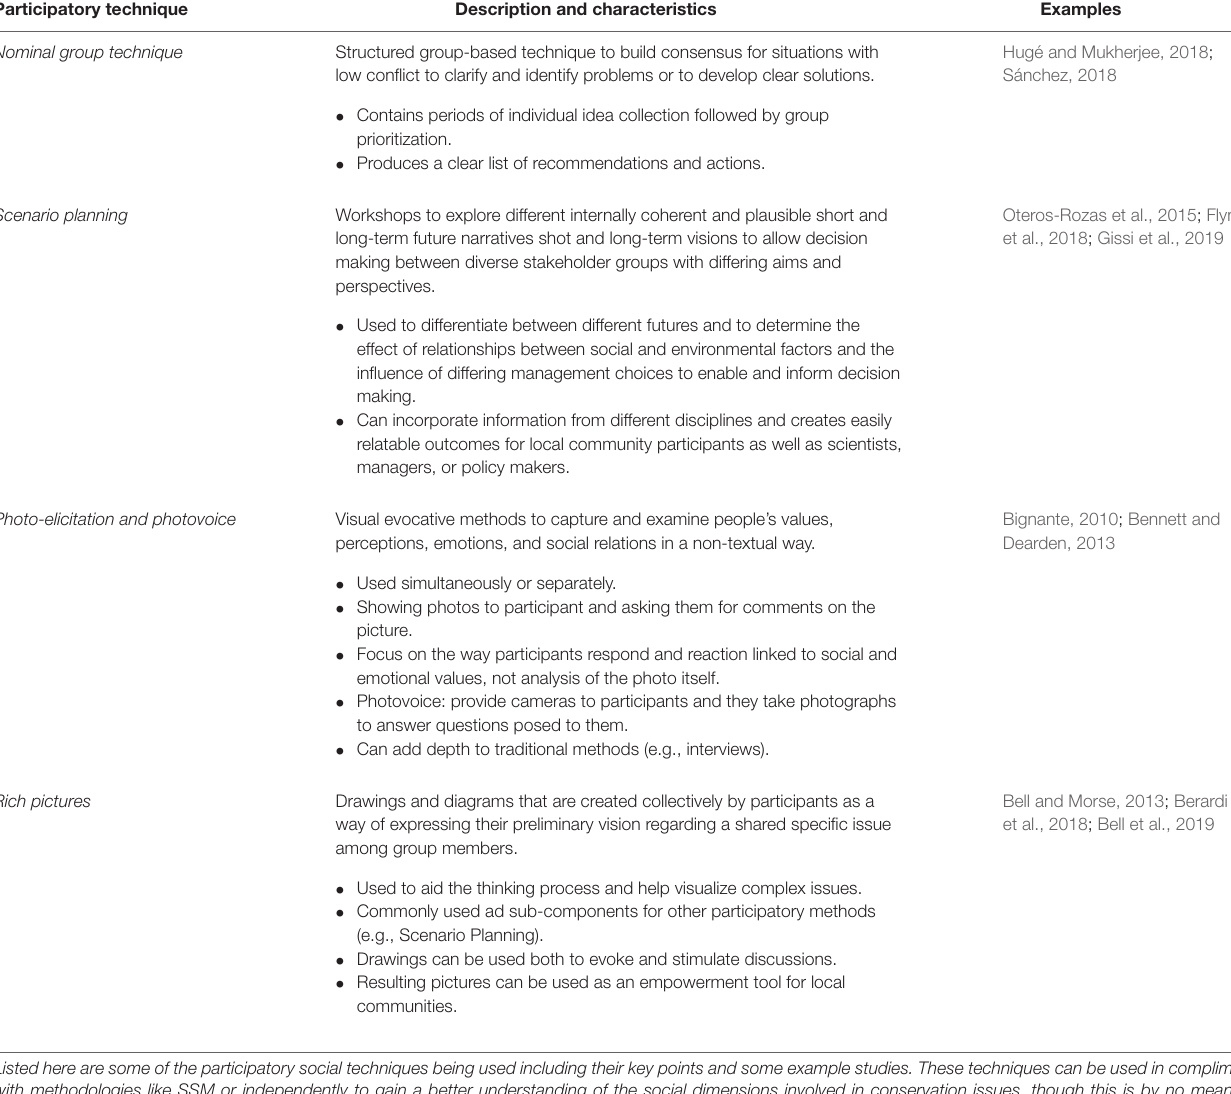
TABLE 3 | Methods traditionally associated with social science are increasingly being used in